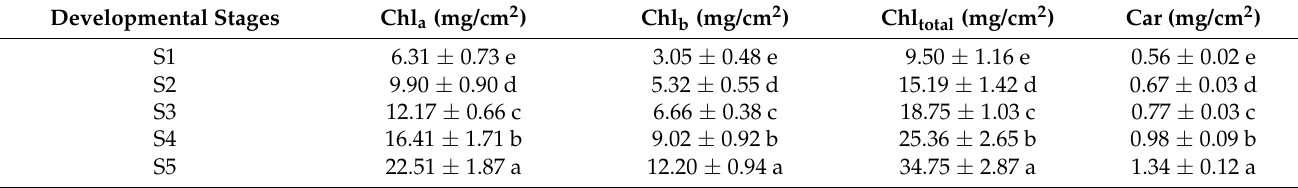
Table 3. Changes in chlorophyll and carotenoid contents in Canephora coffee leaves at different